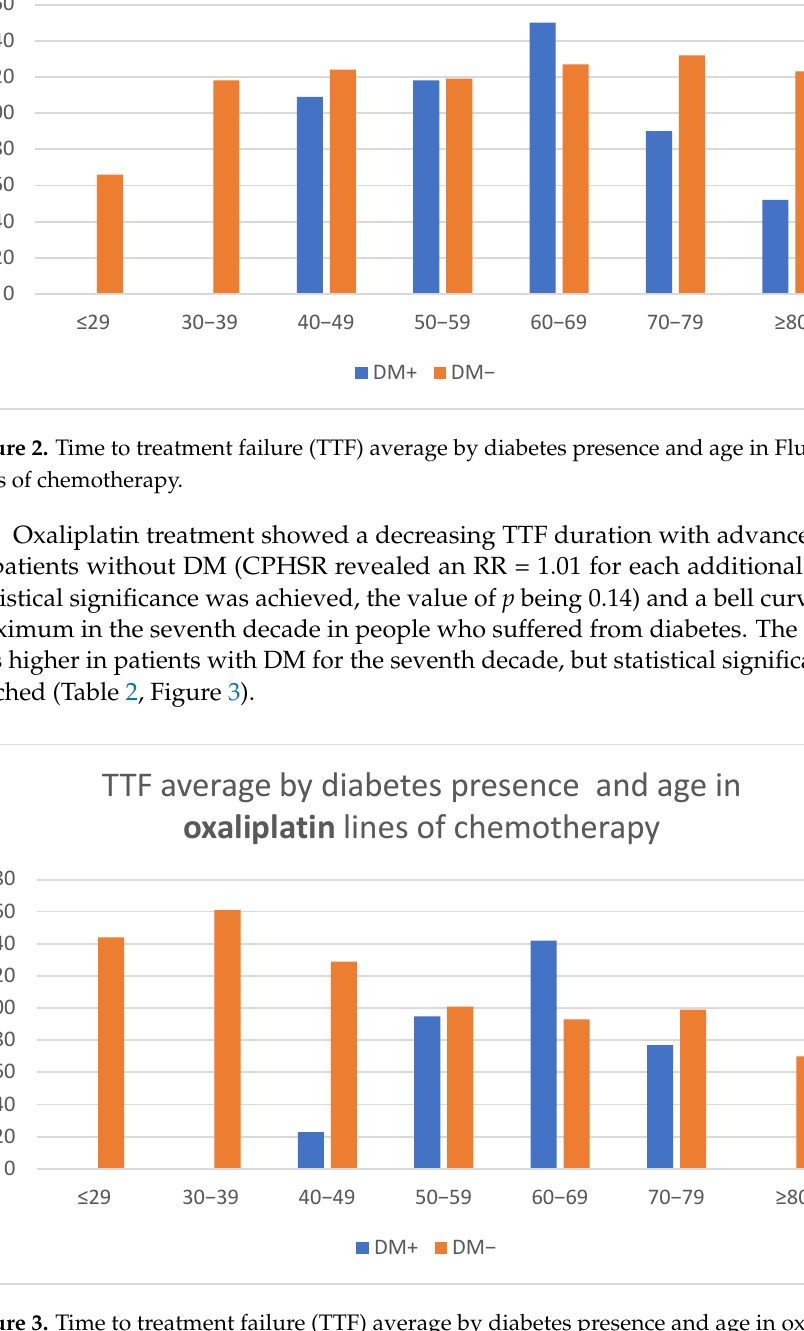
for each additional year, p =